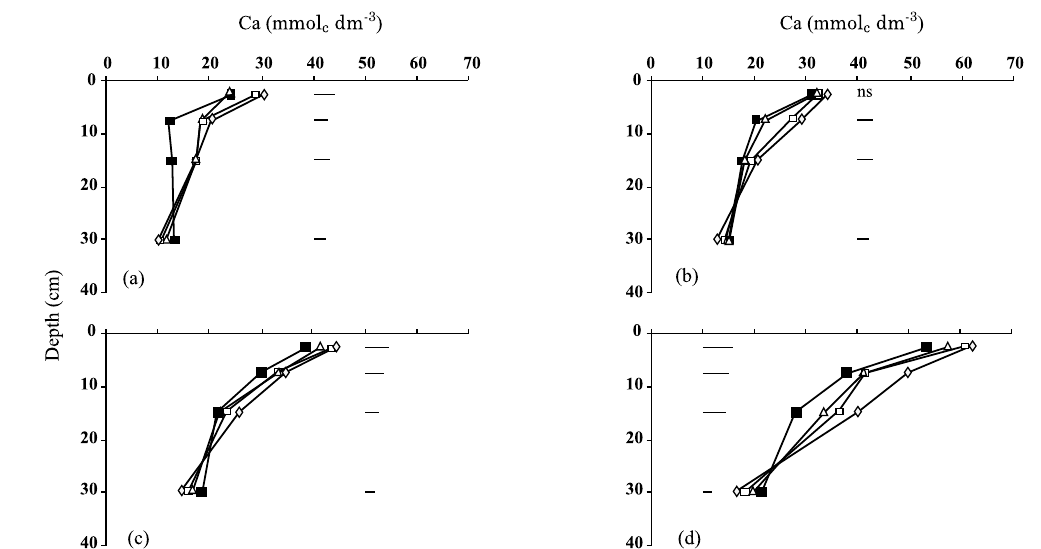
Figure 6. Calcium levels in the soil profile as affected by nitrogen fertilization ( ): 0; ( ): 50; ( ΔΔ ΔΔ Δ ): 100 and ( ): 150 kg ha -1 of N, 18 months after liming ((a): 0; (b): 1500; (c): 3000 and (d): 6000 kg ha -1 of lime). : least significant difference at 5 % by the t test. ns: non